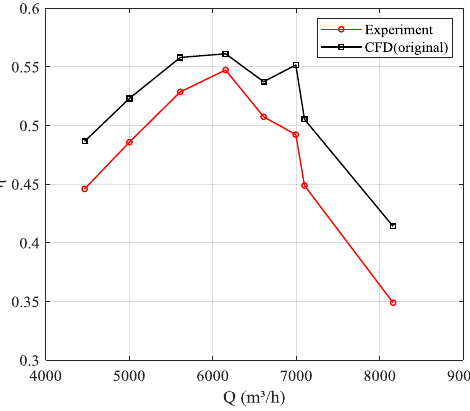
Figure 14. Average e ffi ciencies calculated by CFD and the experiment.